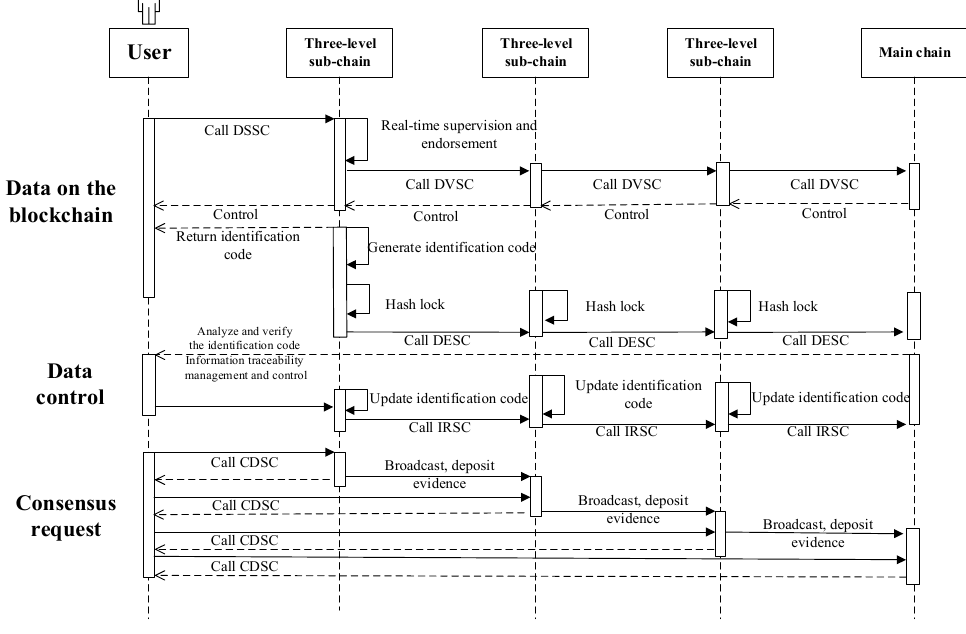
Figure 7. Model running process sequence diagram.